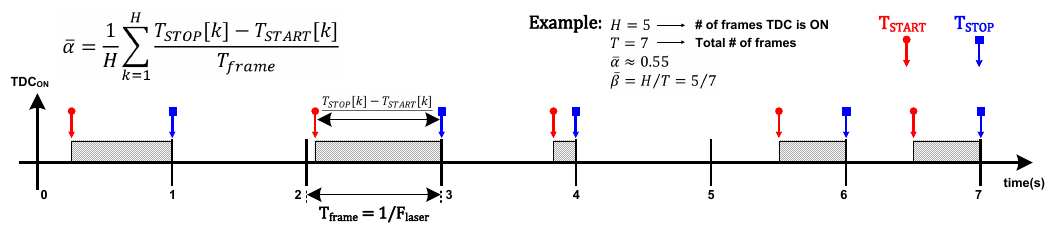
Figure 1. Time diagram example of a single time-to-digital converter (TDC) in event-driven